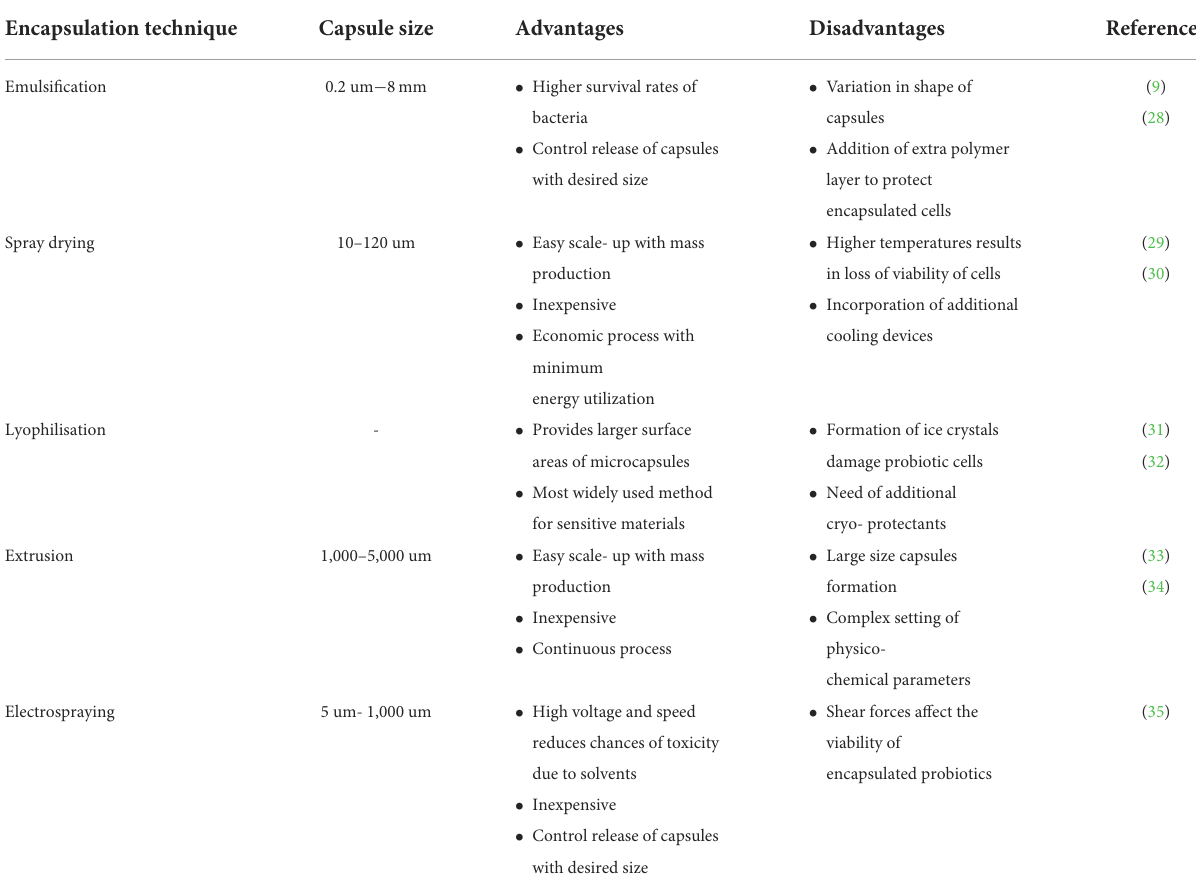
TABLE 1 Advantages and disadvantages of encapsulation